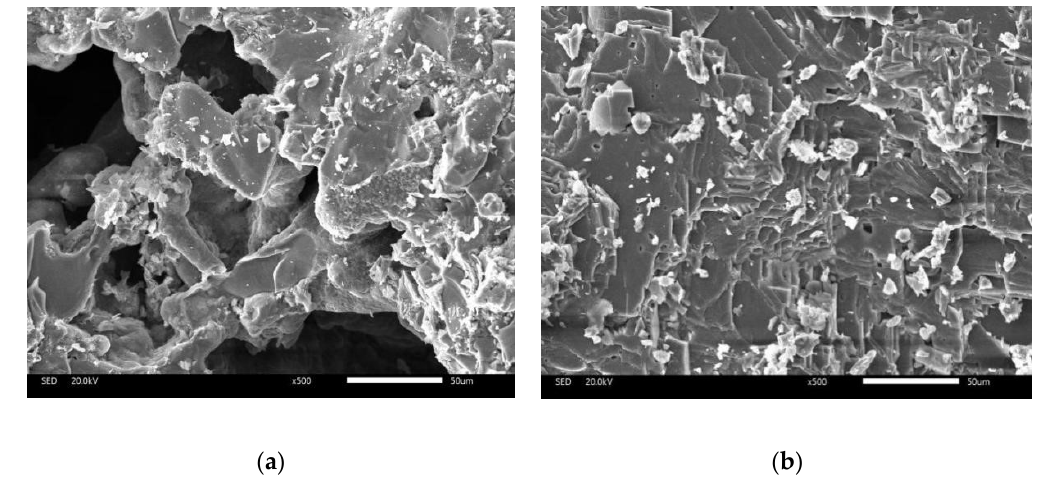
Figure 7 SEM morphology of ( a ) steel slag, ( b ) basalt. Figure 7. SEM morphology of ( a ) steel slag, ( b ) basalt.